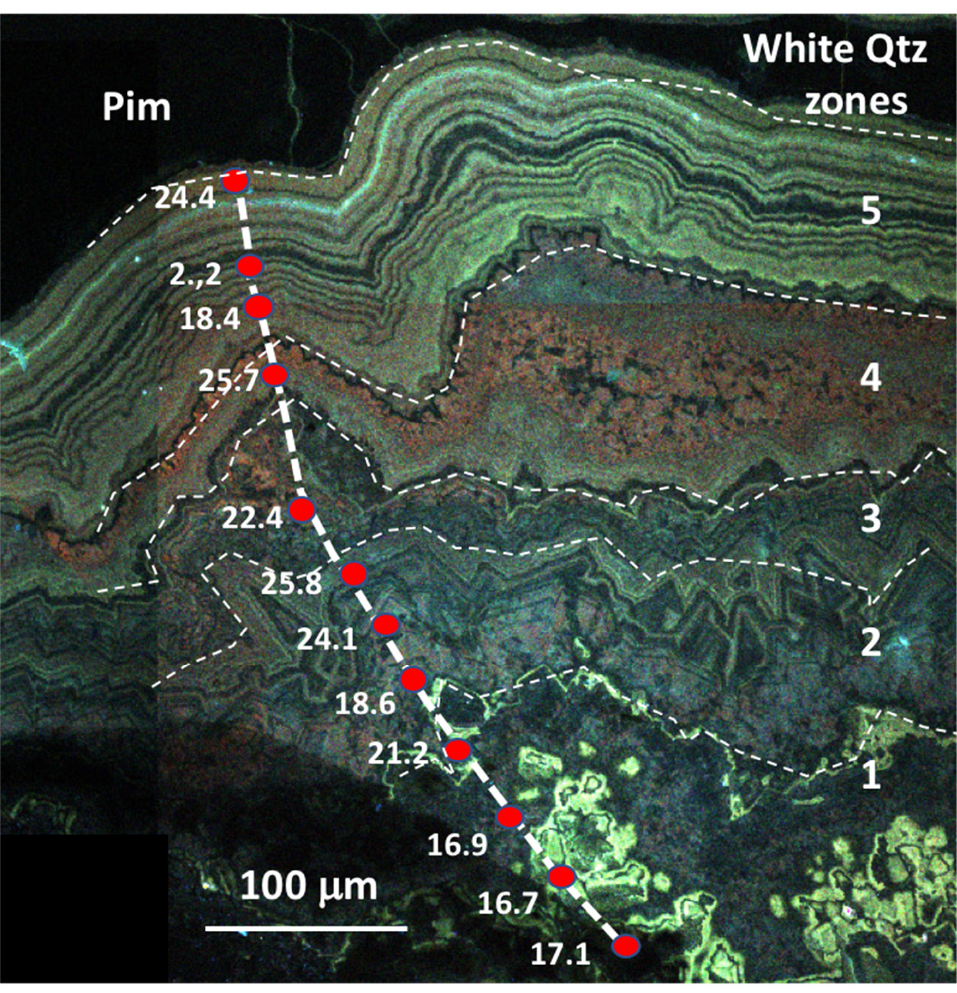
Figure 9. δ 18 O (‰) values along a profile crosscutting white quartz from silicified breccia to the centre of the cavity (Zones 1 to 5). The colloform pimelite appears in black in the central vug. δ 18 O values are reported on the cathodoluminescence image.